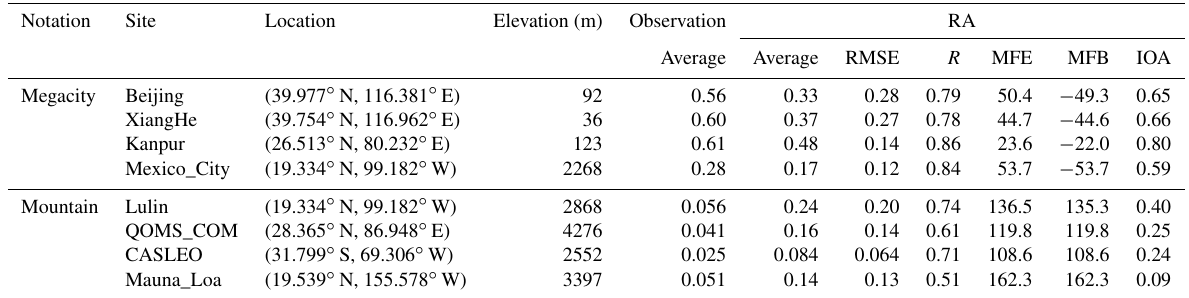
Figure 16. Maps of statistical measures of monthly AERONET AODs versus RA AODs. (a) RMSE, (b) R , (c) MFE, (d) MFB, (e) IOA, and (f) number of data. Table 5. Statistical measures of the monthly AERONET AODs versus FR and RA AOD at megacity and mountain AERONET